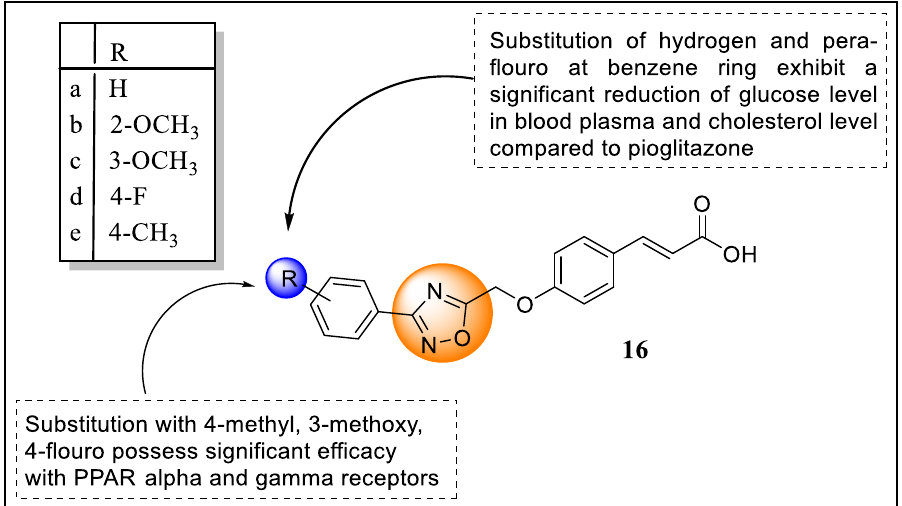
Figure 20. Structural activity relationship of oxadiazole hybrids ( 16 ) as potent PPAR